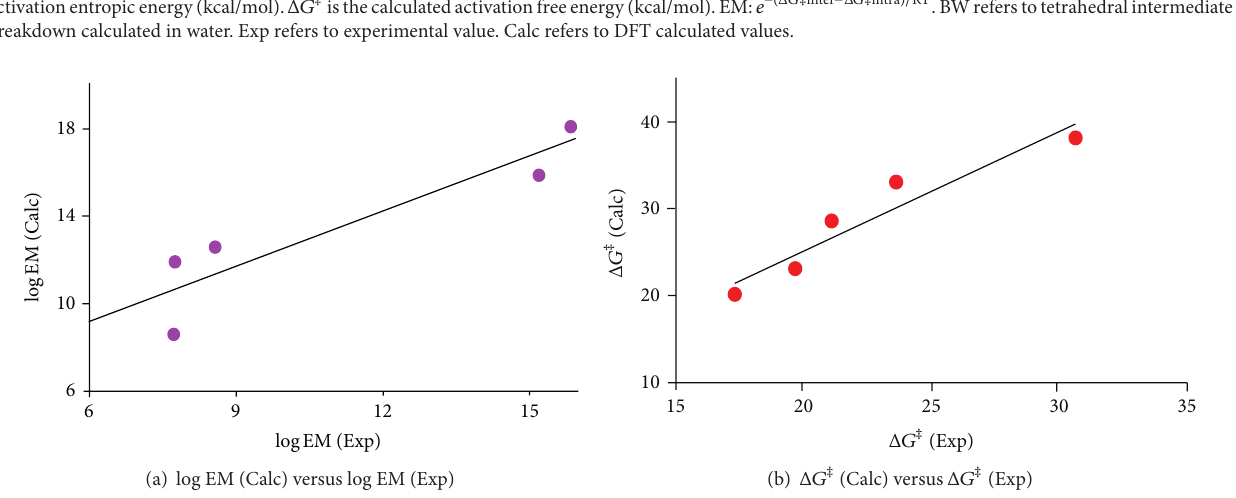
Figure 6: (a) Log calculated effective molarity versus experimental effective molarity for processes 1–5. (b) DFT calculated activation energy (kcal/mol) versus experimental activation energy (kcal/mol) for processes